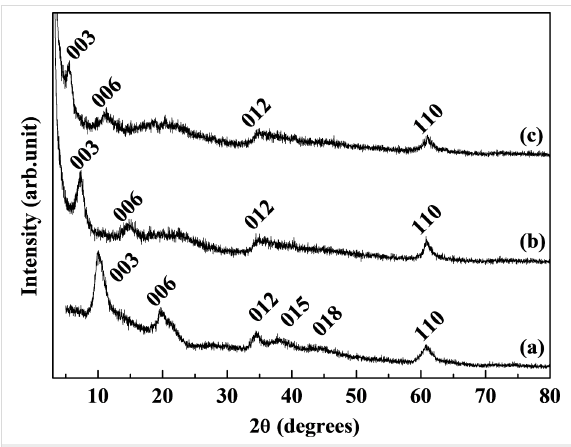
Figure 4: XRD patterns of (a) pristine MgAl-NO 3 -LDH, (b) GL-S and (c) GL-R.